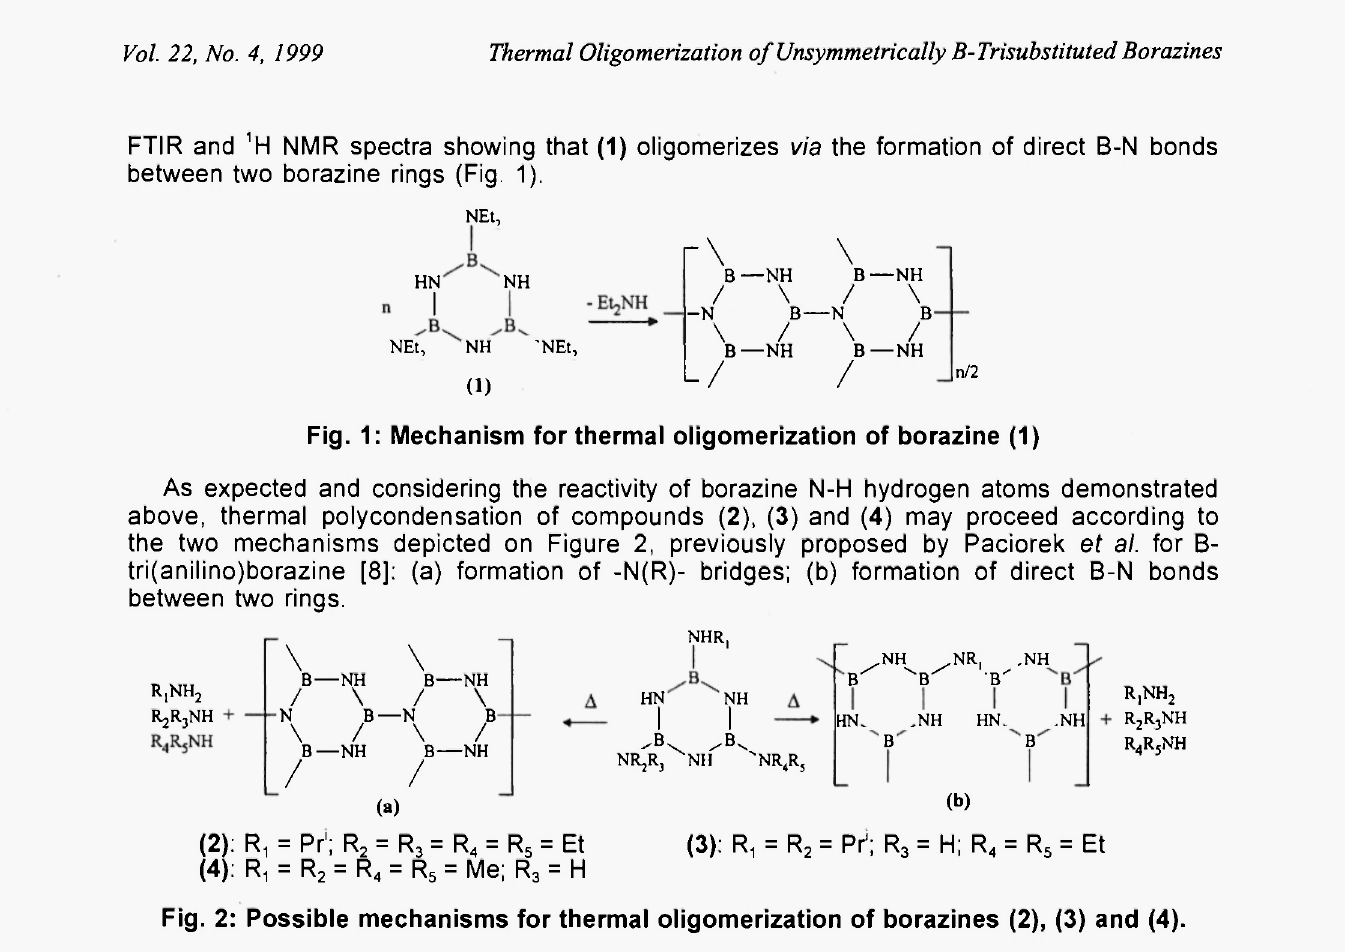
(2): R, = Pr'; R 2 = R 3 = R< = R 5 = Et (4): R, = R 2 = R 4 = R 5 = Me; R 3 = Fig. 2: Possible mechanisms for thermal oligomerization of borazines (2), (3) and (4).